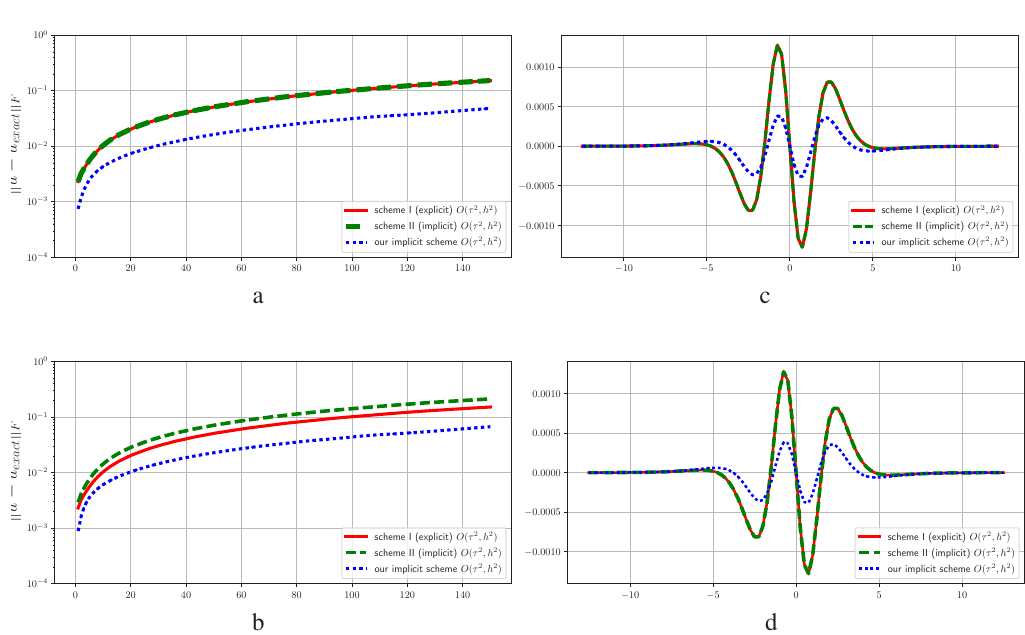
Figure 1. The time dynamics of descrepancy (12) for with τ = h / 10 (a) and τ = h (b) for the implicit schemes, and the values (c) and (d) of the left-hand sides of the modified equations for these values of τ ,